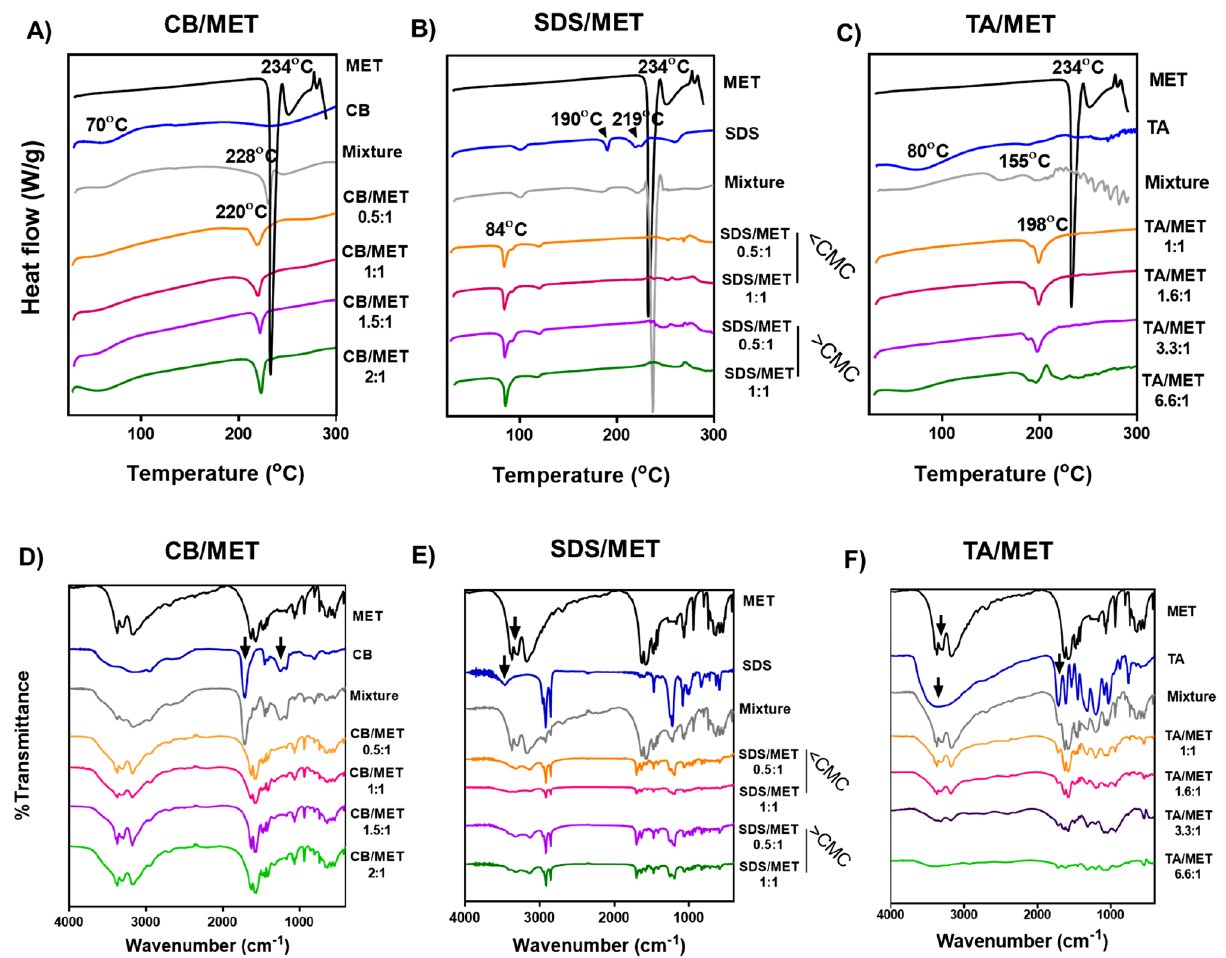
Figure 3. Differential scanning calorimetry (DSC) thermograms ( A – C ) and FTIR spectra ( D – F ) of metformin hydrochloride (MET) complexes. Complexes prepared using Carbopol (CB), sodium dodecyl sulfate (SDS), and tannic acid (TA) prepared at different charge ratios. Spectra are compared to that of free MET and ligands (CMC; critical micelle concentration, Mixture; the physical mixture of MET and ligand at 1:1 charge